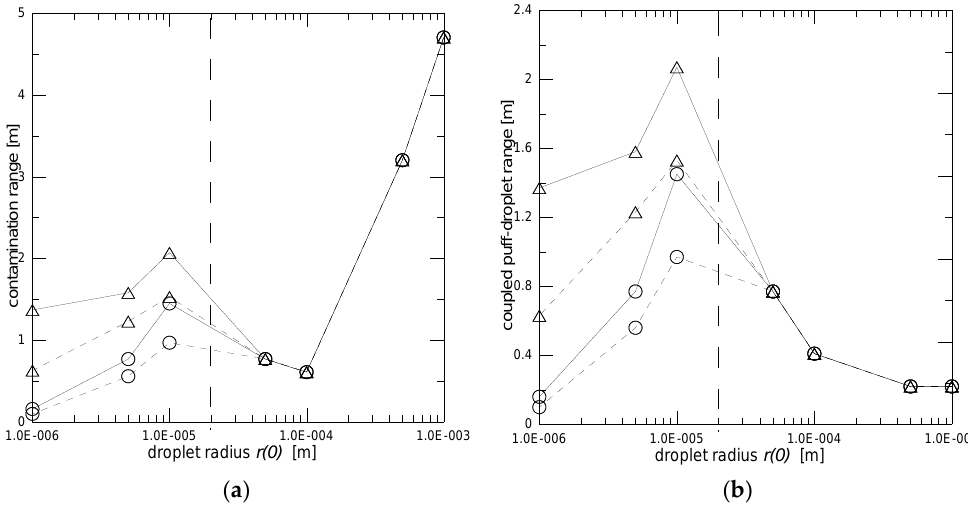
Figure 1. Contamination range ( a ) and the coupled puff-droplet horizontal range ( b ), as a function of the initial droplet radius in cold (triangles, 5 °C) and warm environments (circles, 35 °C). Continuous line: Rh = 0.8, dashed line: Rh = 0.40 (connection lines are added to help visualization only). The vertical dashed line approximately separates the two regions in which evaporation (left) or inertia-gravitational settling prevails.